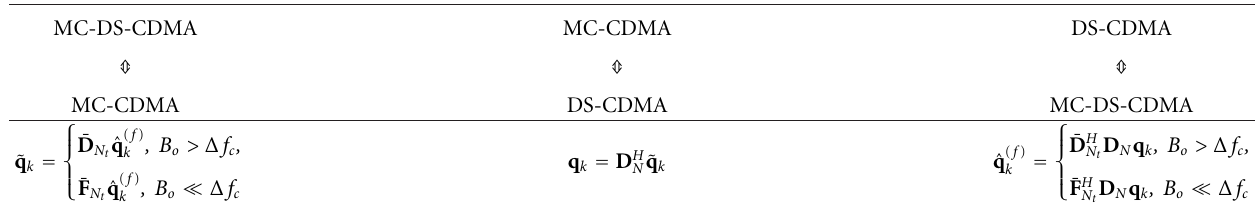
Table 2: Summary of equivalence results for an FS channel. B o refers to the basis waveform bandwidth in an MC-DS-CDMA system. MC-DS-CDMA